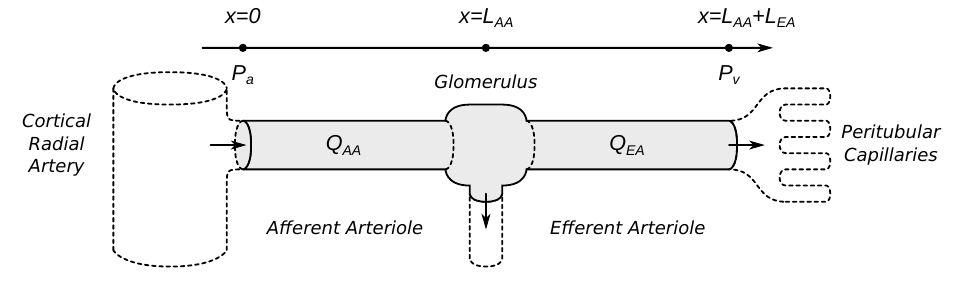
Figure 1. Model vasculature. Blood flows through the afferent arteriole from the cortical radial artery to the glomerulus and subsequently flows through the efferent arteriole from the glomerulus to the peritubular